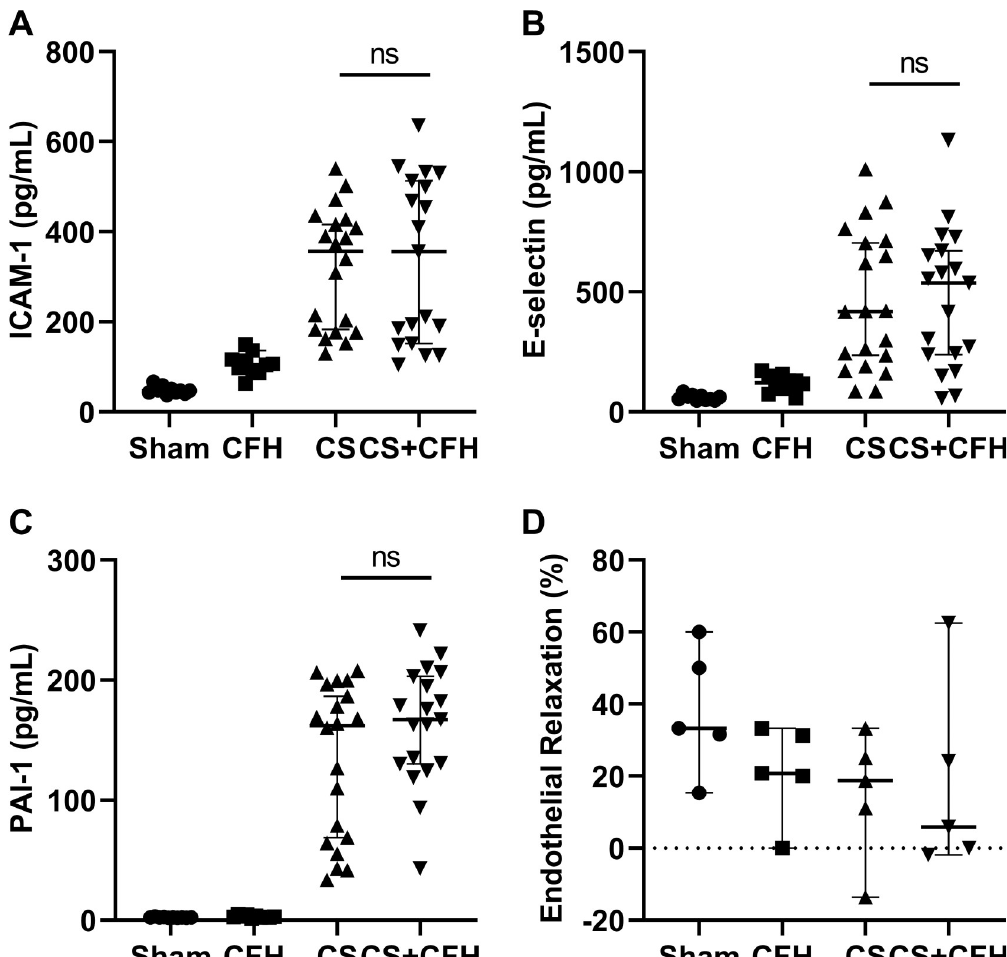
Fig 3. CFH causes vascular injury in murine sepsis. Markers of endothelial injury (n = 10–22), (A) ICAM-1, (B) E-selectin, and (C) PAI-1 were measured 24 hours after CS or CS+CFH treatment. All three markers are elevated in CS and CS+CFH groups but do not statistically differ from each other. (D) To test whether large vessel injury was induced by CFH, we measured aortic relaxation in response to acetylcholine in excised aortas 24 hours after treatment. CFH did not worsen aortic relaxation when combined with CS treatment (n =